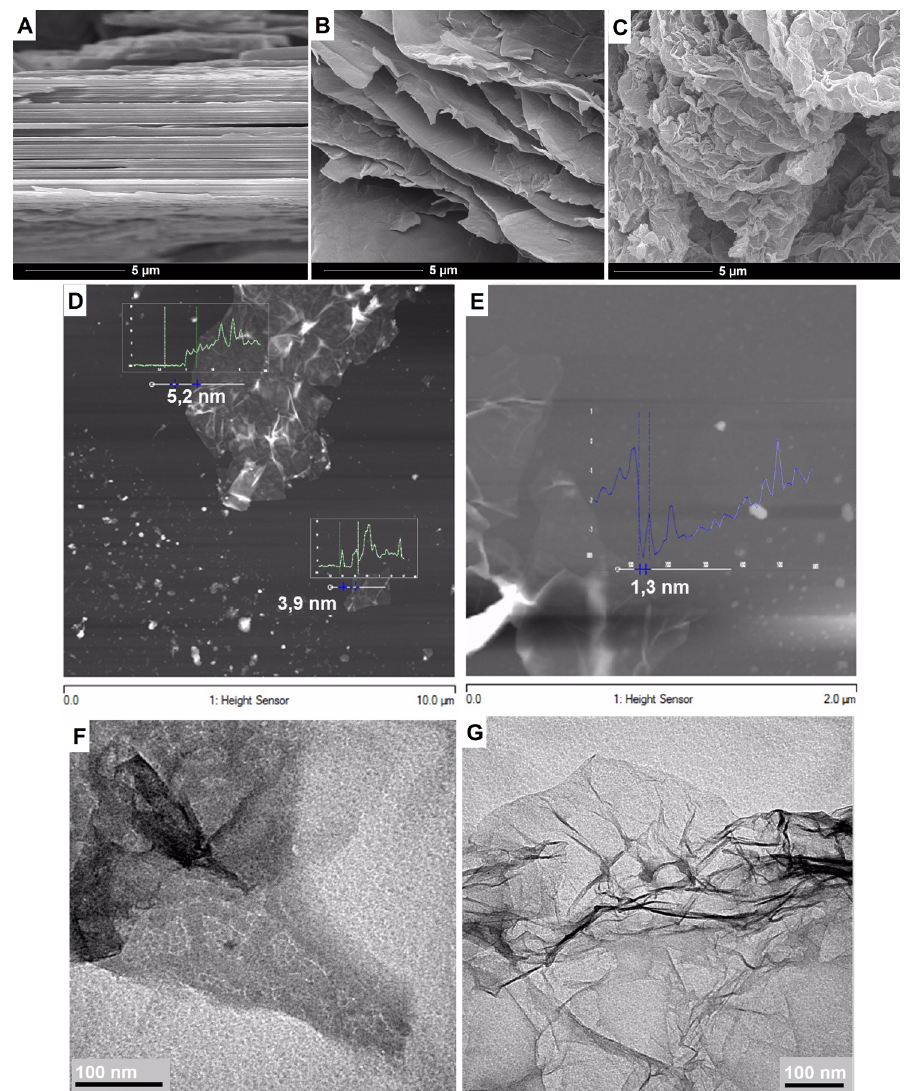
Figure 1. FESEM images of FINE (A), GO (B) and RGO (C). AFM images of GO (D) and RGO (E). TEM images of GO (F) and RGO